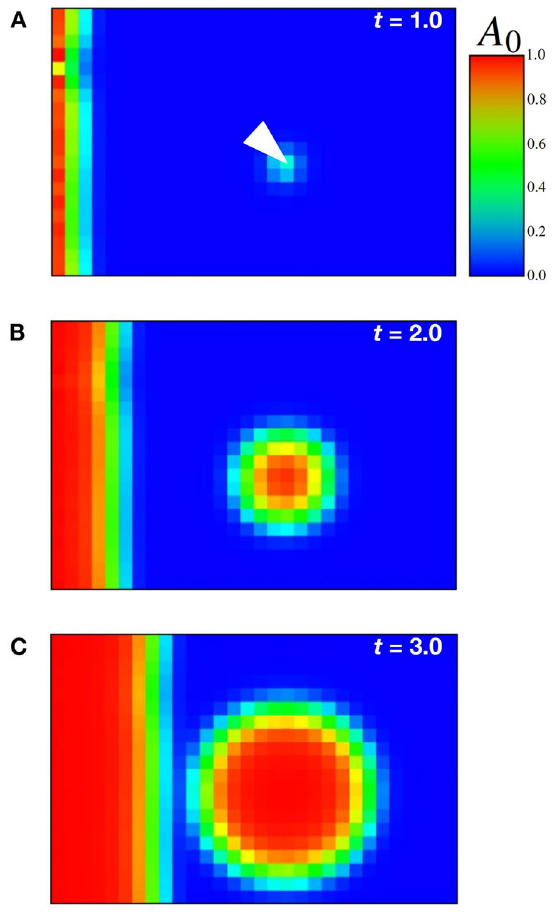
Figure 2. Minor perturbation of EGF signaling away from the wavefront causes spontaneous NB differentiation in Model 1. The small perturbation is imposed on E at the white arrow in the initial condition as shown in ( A ). The parameters are d e = 2.0, k e = 1.0, a e = 4.0, k n = 3.0, d t = 2.0, d c = 0.1, k d = 3.0, a d = 4.0, e a = 10.0 and A 0 = 1.0. Panels ( A – C ) correspond to the profiles of A at t = 1.0, t = 2.0, and t = 3.0, respectively. The high and low expression levels of A are shown in red and blue as indicated in the color